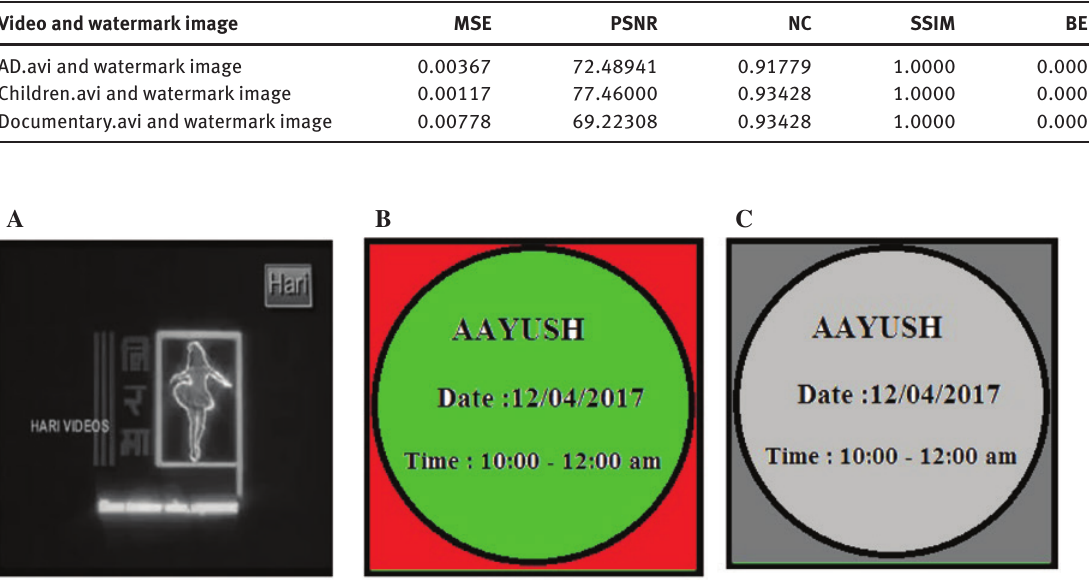
Figure 9: Cover Video Frame, Watermark Image, and Extracted Watermark Image. (A) Cover Video; (B) Watermark Image; (C) Extracted Image.